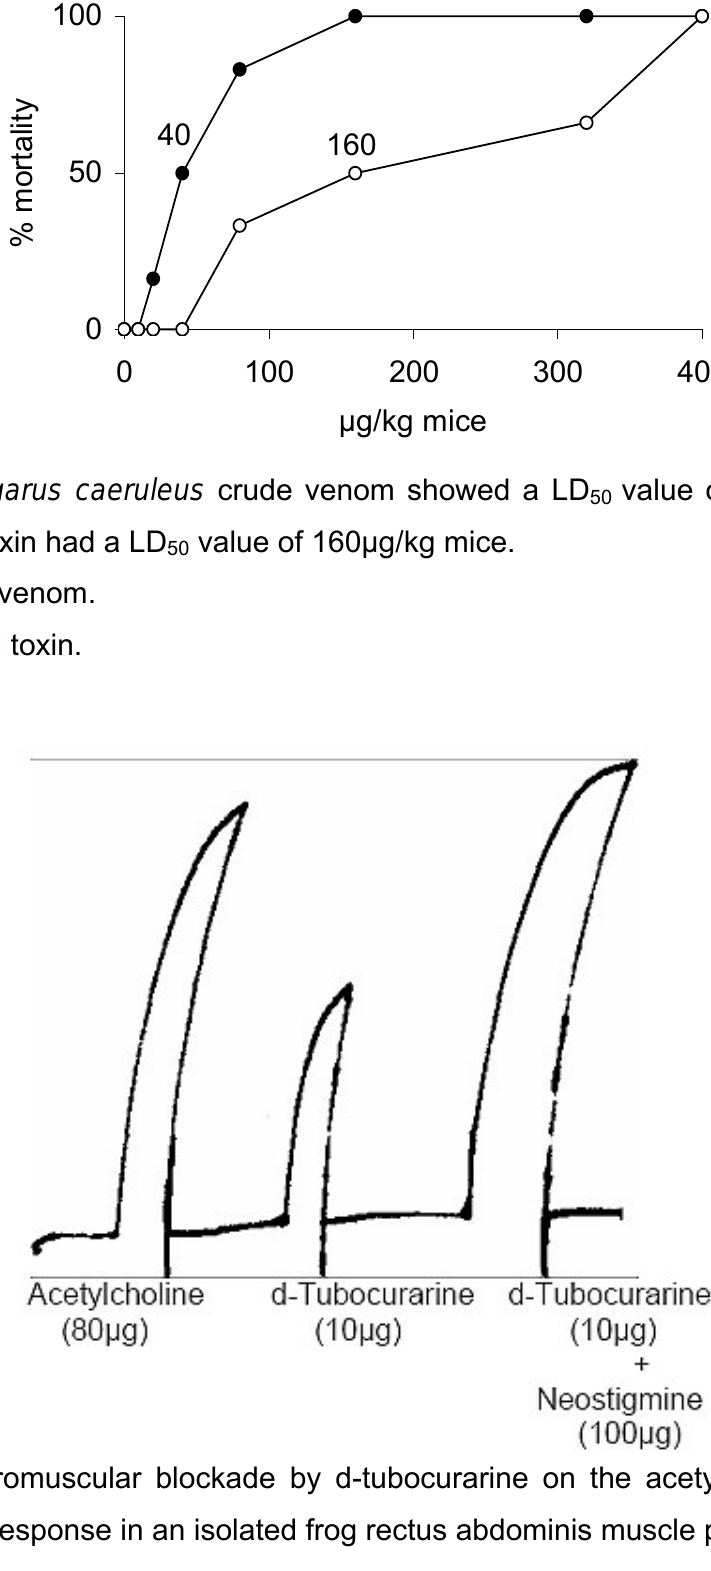
Figure 3: Neuromuscular blockade by d-tubocurarine on the acetylcholine-induced muscle twitch response in an isolated frog rectus abdominis muscle